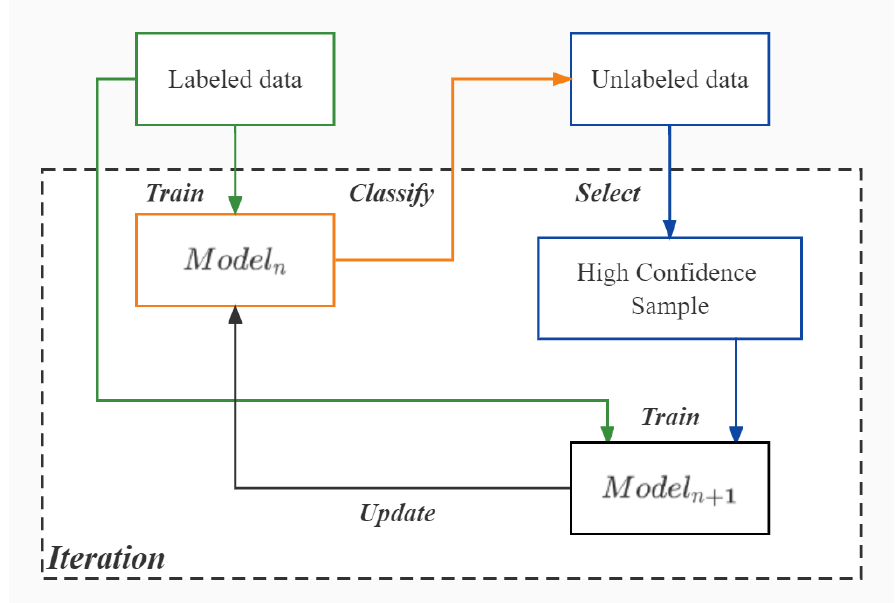
Figure 2. Procedure of semi-supervised learning.